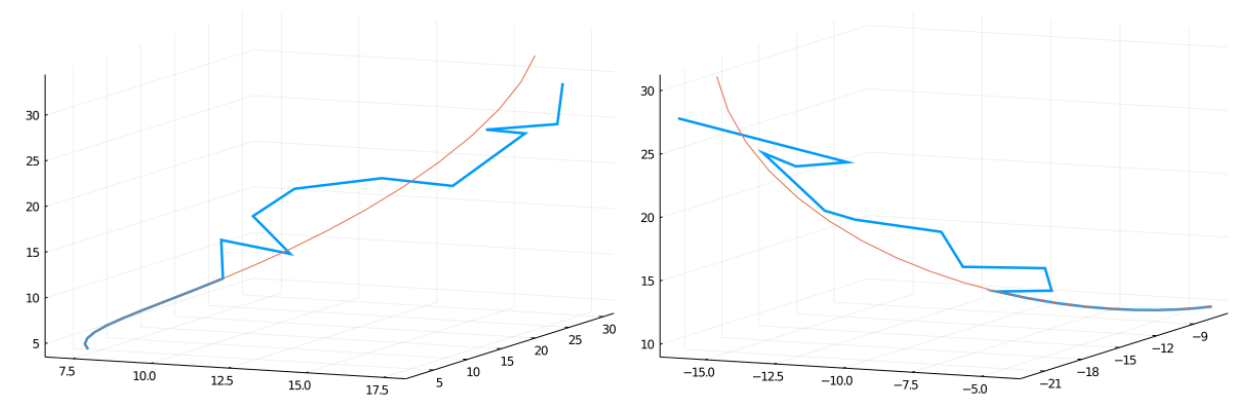
Figure 8. 10-step ahead path predictions.